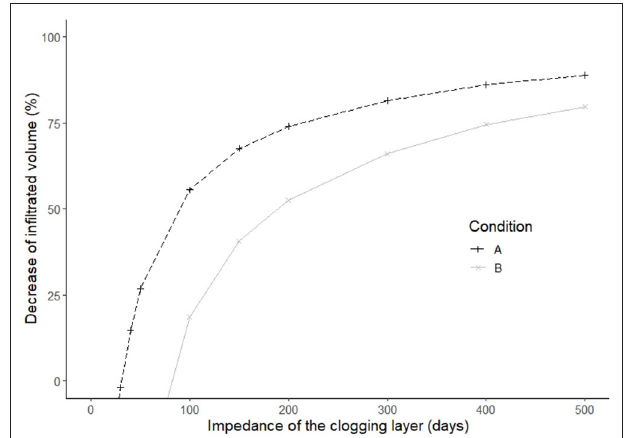
FIGURE 7 | Decrease of average annual infiltrated water volume when a clogging layer is present, relative condition A and B, as a function of clogging layer